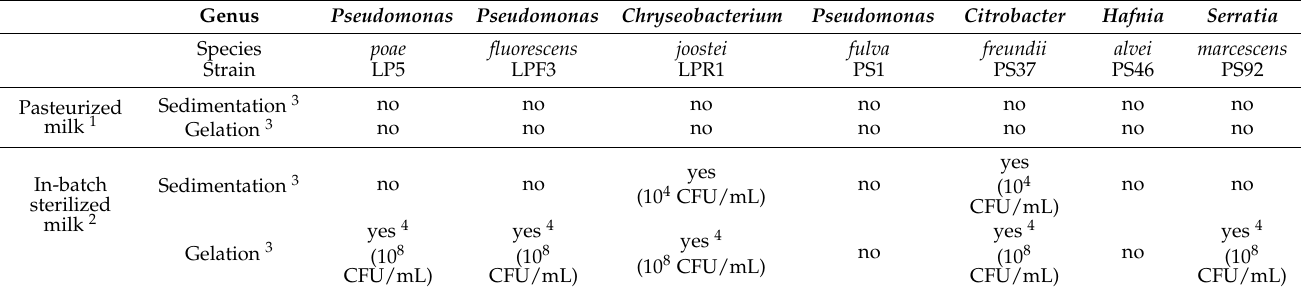
Table 2. Physical phenomena occurring in pasteurized samples inoculated with the psychrotrophic strains and in the in-batch sterilized